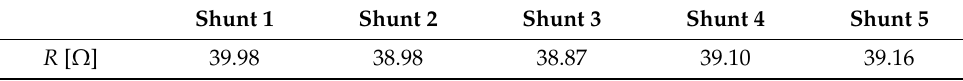
Table 2. Current shunts resistance values.